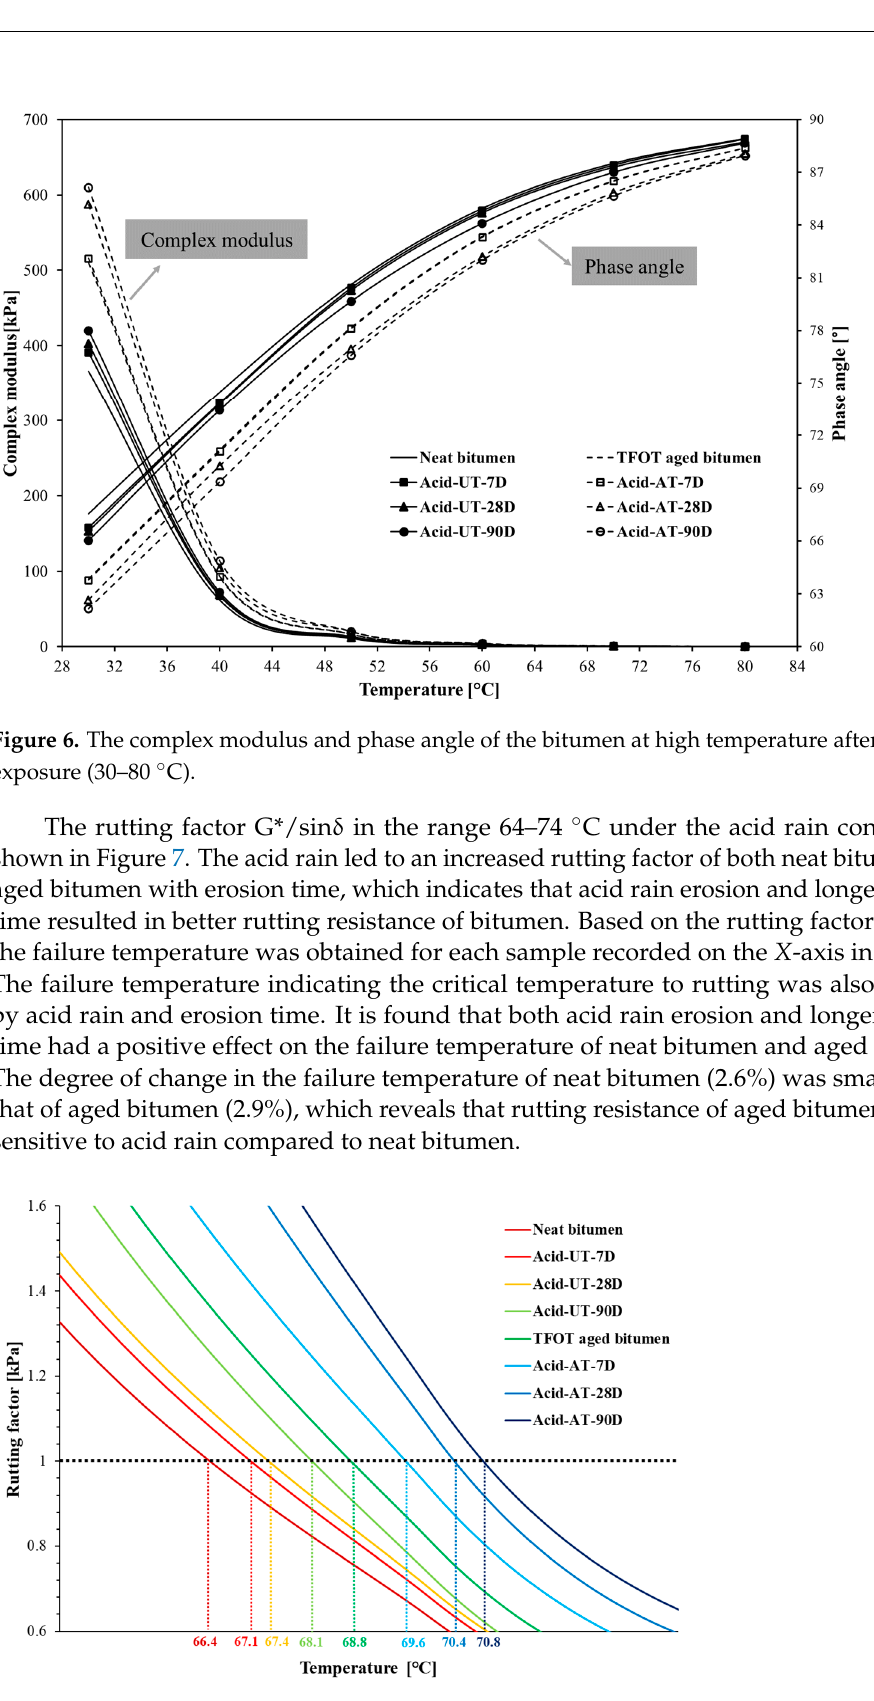
Figure 7. The rutting factor and failure temperature of bitumen.